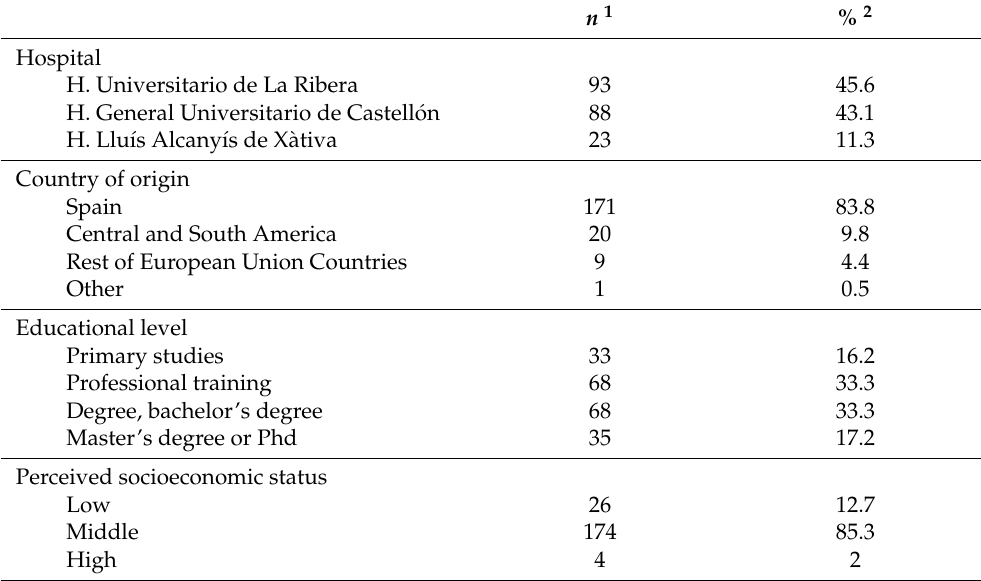
Table 4. Sociodemographic Characteristics.